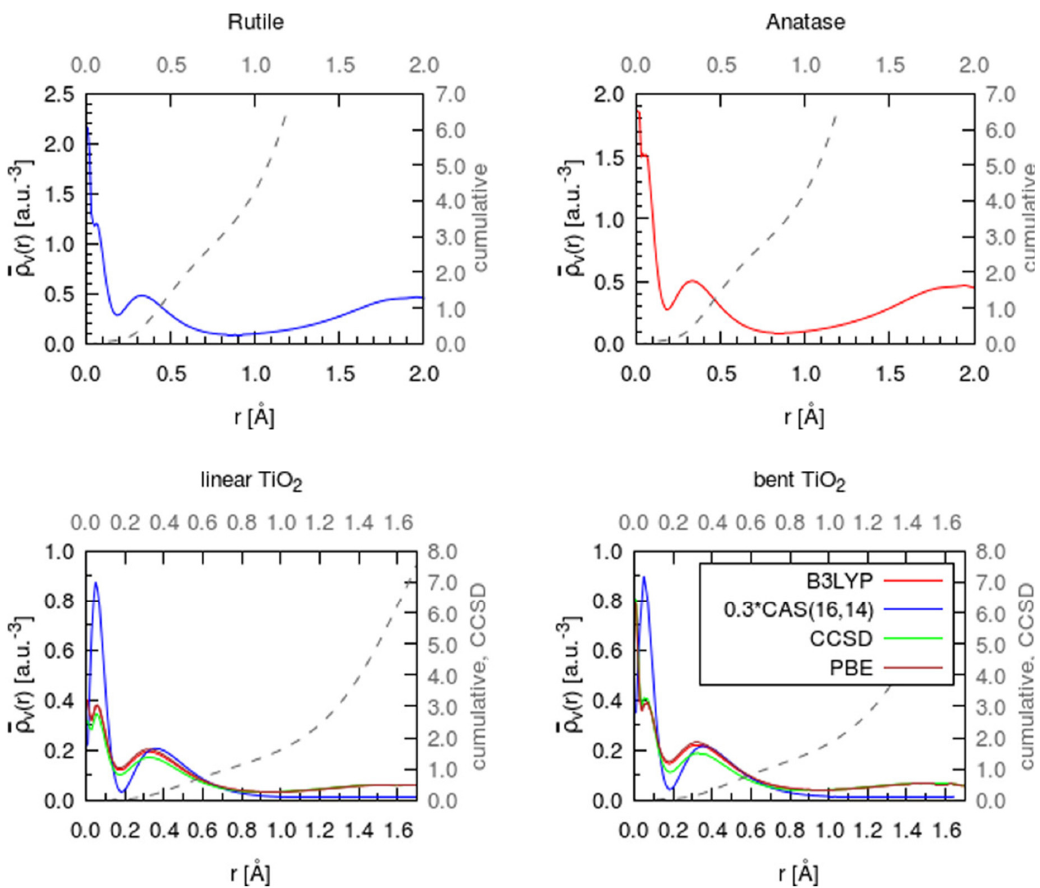
Figure 4. Top panels: spherically averaged valence electron density around the Ti atom of a periodic rutile and anatase structure calculated with PBE. The spatial coordinate r corresponds to the radial distance from one Ti center. The O atoms are located at r = 1.96 A in rutile and r = 1.95 and 2.01 Å in anatase. Bottom panels: spherically averaged valence electron density of a linear and bent TiO 2 molecule obtained with B3LYP, CAS(14,16), CCSD, and DFT PBE. The CAS(16,14) curve is scaled by a factor of 0.3 for a better comparison. The gray, dashed lines indicate the cumulative numbers of electrons within the spheres of corresponding radii. Adapted with permission from Ref. [15]. Copyright 2017 American Chemical Society.